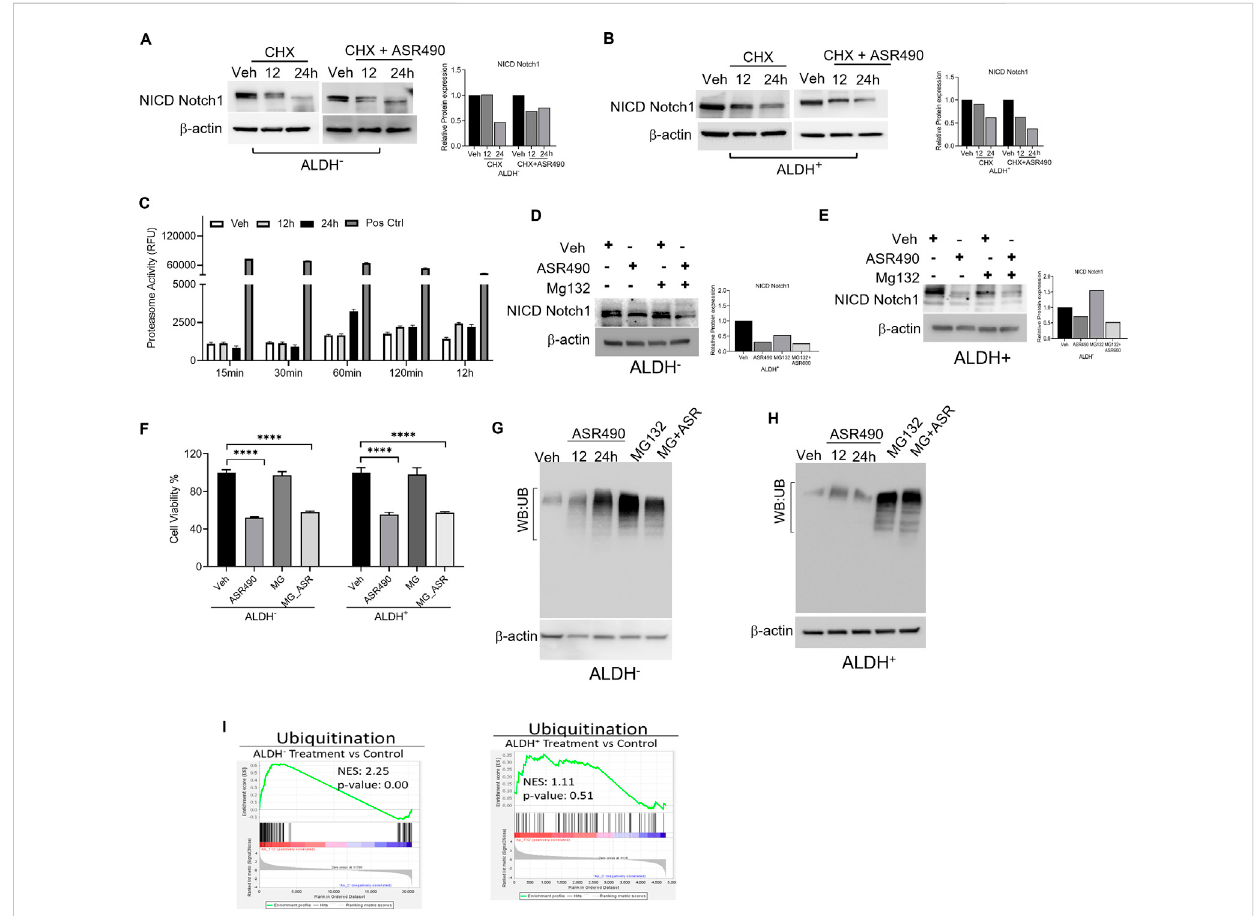
FIGURE 4 Molecular signaling responsible for NICD downregulation in ASR490 treated in ALDH − and ALDH + cells. (A, B) Western blots performed for Notch1- NICD expression in ALDH − and ALDH + cells treated with ASR490, CHX (50 µM), or combinations at the indicated time points. (C) Proteasome activity measured for ALDH + cells treated with ASR490 at the indicated time points. (D, E) Western blots showing Notch1-NICD expression in ALDH − and ALDH + cellstreatedwithASR490,MG132(10 µM),orcombinationsattheindicatedtimepoints. (F) MTTcellviabilityassaysperformedonALDH − andALDH + following treatment with ASR490, MG132, or combinations ( n = 6; **** p < 0.0001). p values are based on one-way ANOVA with a post hoc LSD test. (G, H) Western blots for ubiquitin protein expression performed for ASR490-treated ALDH − and ALDH + cells. MG132 was used as a positive control. (I) GSEA of RNA-seq data demonstrating alterations in ubiquitin signaling in ASR490-treated ALDH + and ALDH −